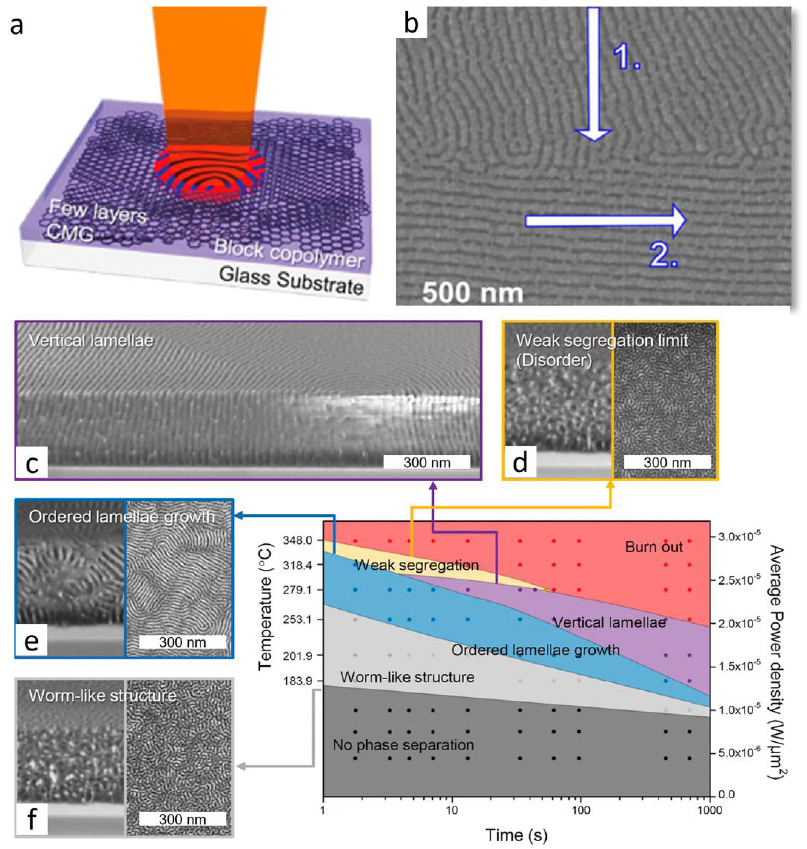
Figure 6. ( a ) Schematic of the laser zone annealing process. ( b ) Local patterning via soft-shear laser zone annealing (SS-LZA) of PS- b -PMMA, note the perpendicular junction from the two orthogonal laser sweeps [91] . ( c – f ) BCP self-assembly of the PS- b -PMMA blended with the short neutral ran- dom copolymer chains of PS- r -PMMA (7:3 weight ratio) under the transient laser photothermal treatment at increasing intervals of heat and time [98] . Adapted with permission from references [91,98]